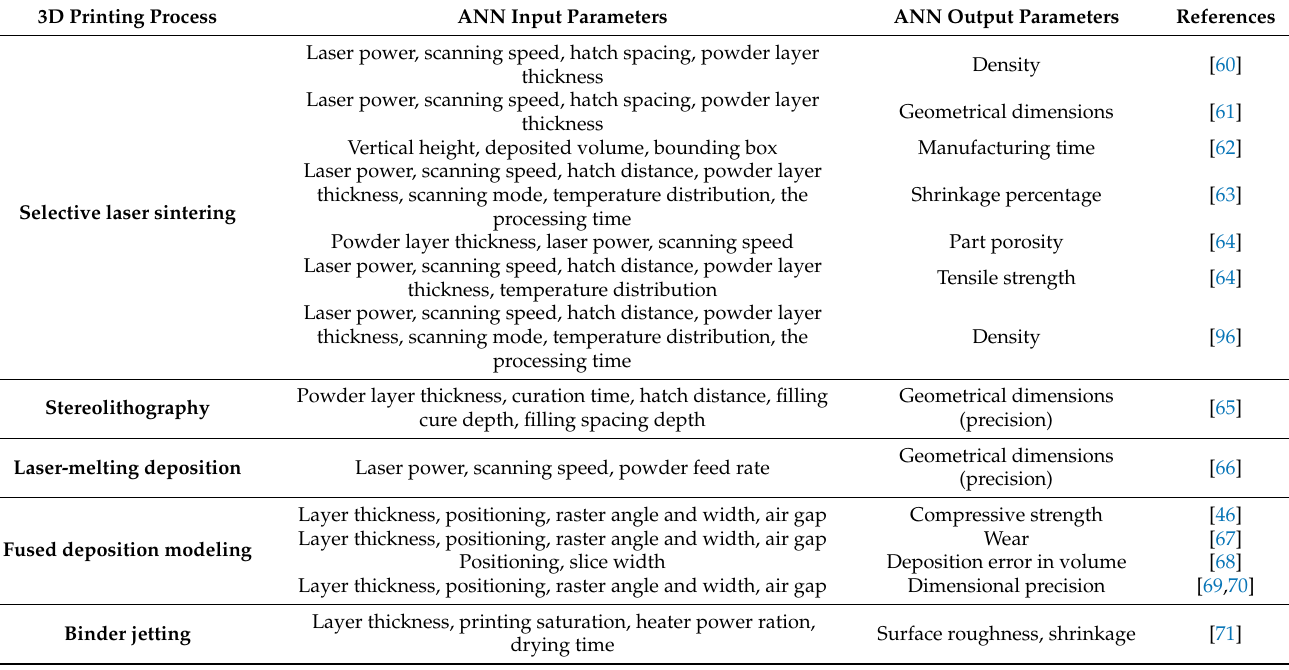
Table 6. Applications of an ANN in the field of 3D